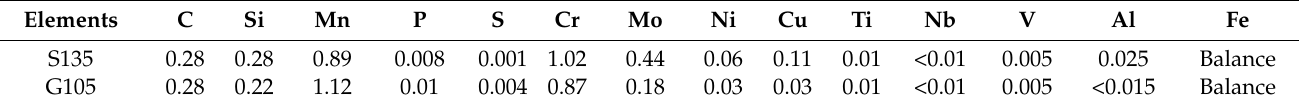
Table 1. Chemical compositions of S135 and G105 steels (wt.%).